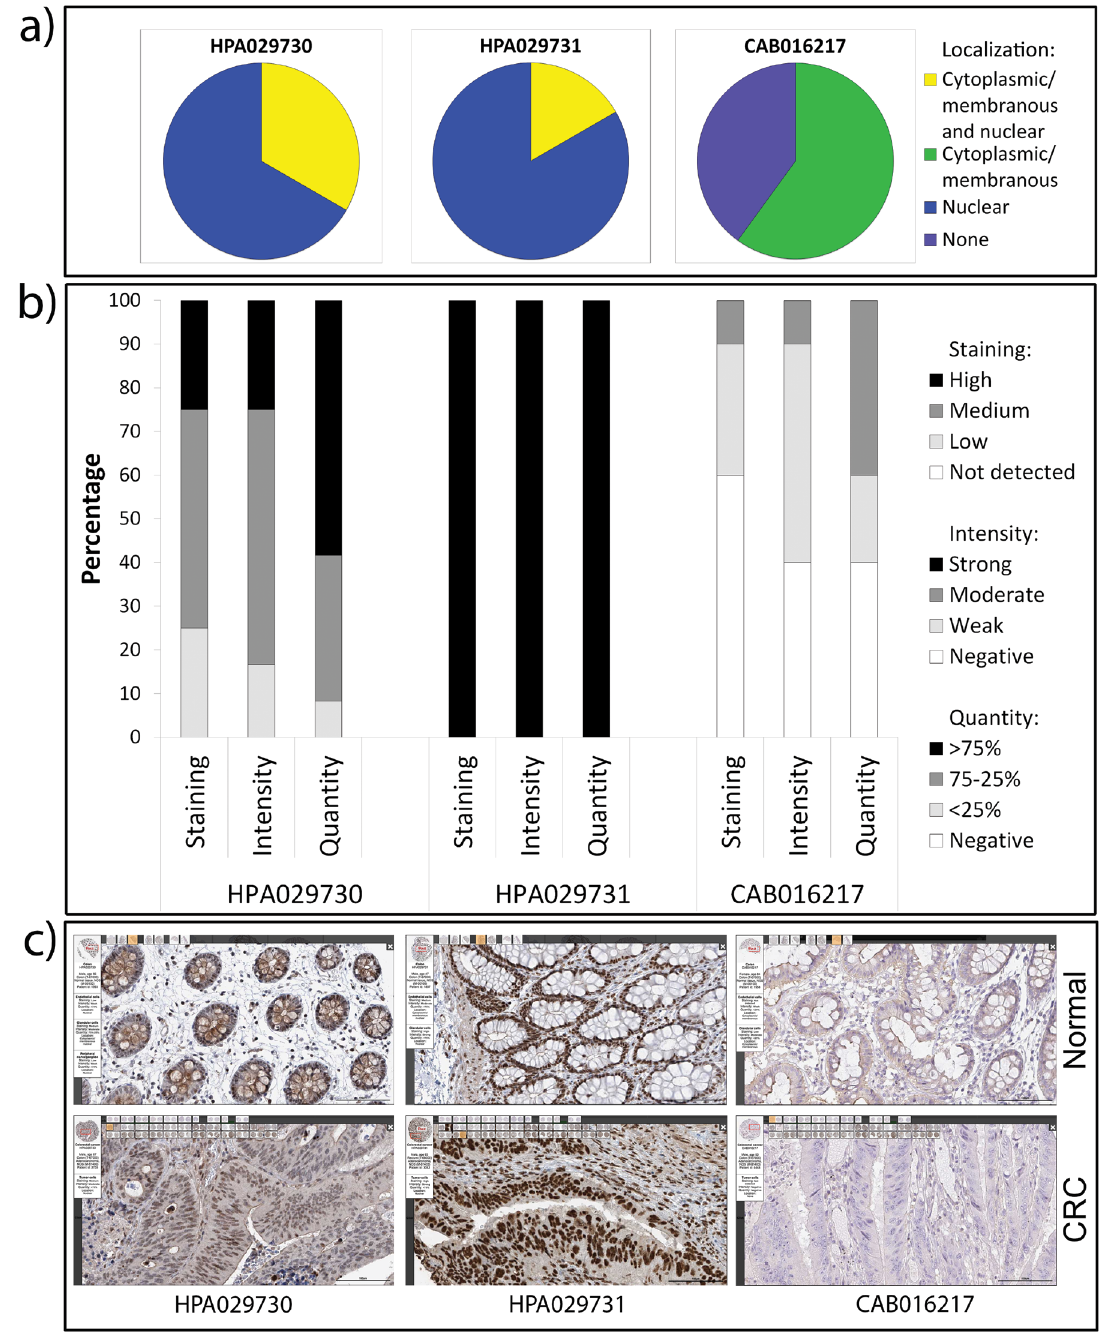
Supplemental Figure 3. Comparison of GATA3 staining patterns in CRC tumor samples in the Human Protein Atlas (HPA) using three different antibodies. a ) Subcellular localization; b ) Staining, intensity, and quantity plots from the HPA. c ) Representative images from matched normal colon tissue and CRC samples with three different GATA3 antibodies, as